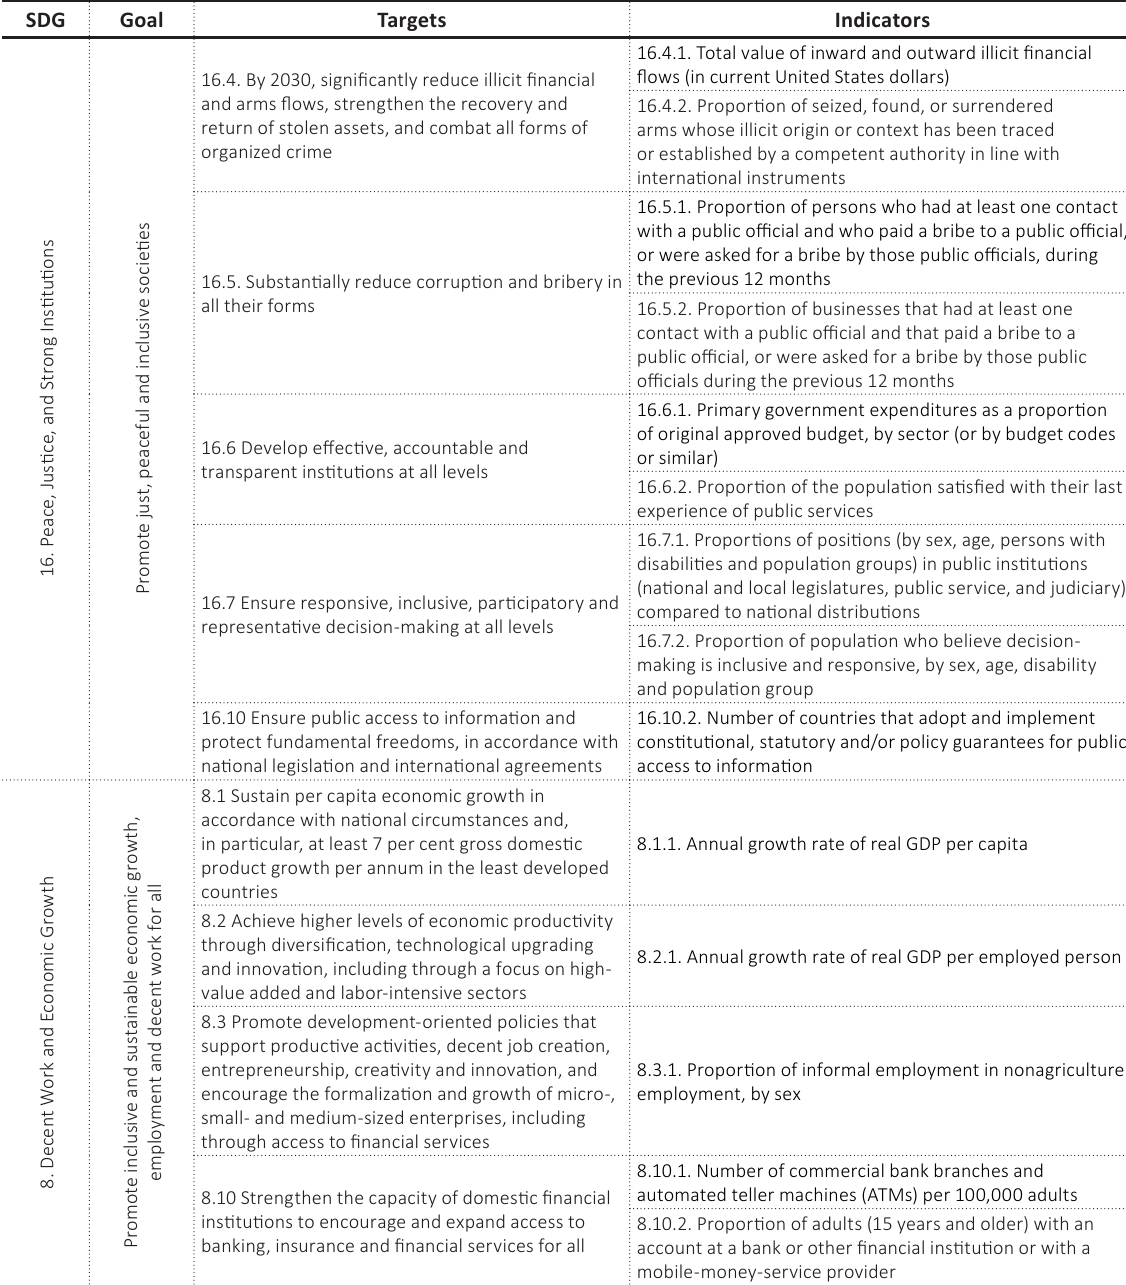
Source: UN General Assembly